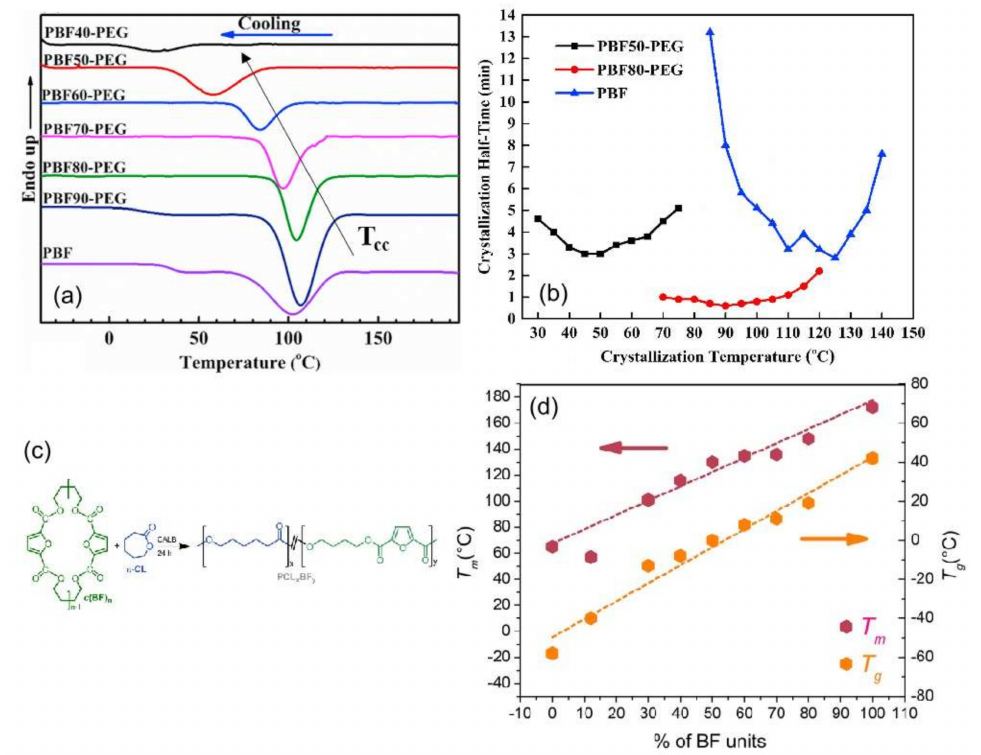
Figure 4. ( a ) DSC cooling scans of PBF- co -PEG block copolymers, ( b ) crystallization half-time for PBF50-PEG, PBF80-PEG copolymers, and neat PBF [89], ( c ) e-ROP reaction leading to PBF- co -PCL copolyesters and ( d ) T m and T g of PBF- co -PCL against the content of the polymer in butylene furanoate units [86].